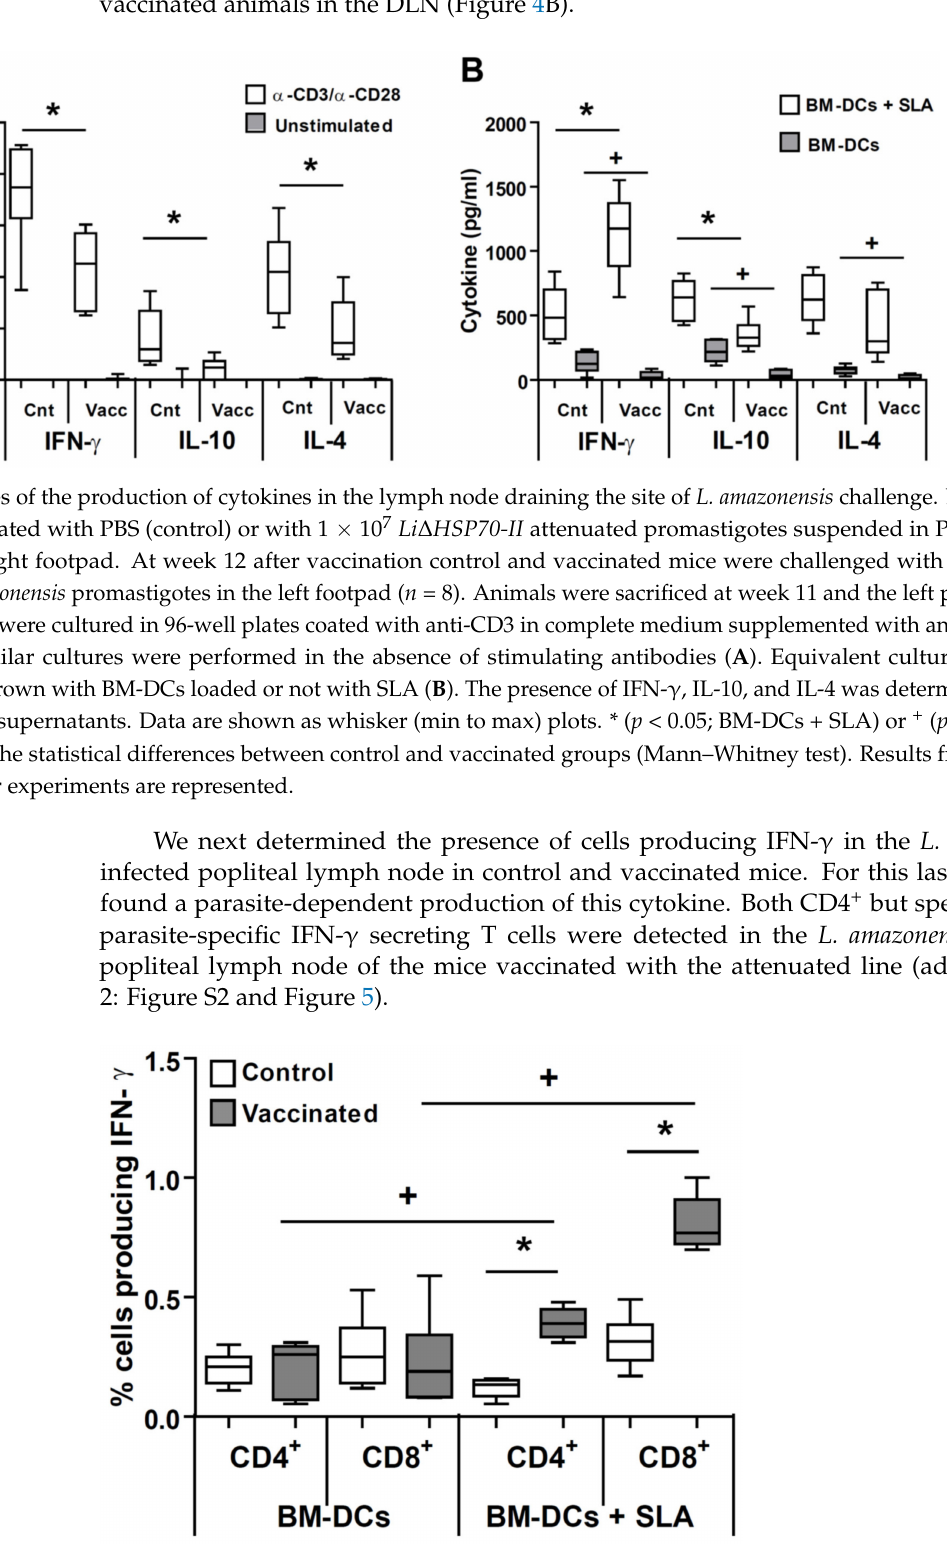
Figure 5. Involvement of T cells in the parasite-dependent production of cytokines. BALB/c mice were inoculated with PBS (control) or with 1 × 10 7 Li ∆ HSP70-II attenuated promastigotes suspended in PBS (vaccinated) in the right footpad. At week 12 after vaccination control and vaccinated mice were challenged with 1 × 10 6 stationary L. amazonensis promastigotes in the left footpad ( n =